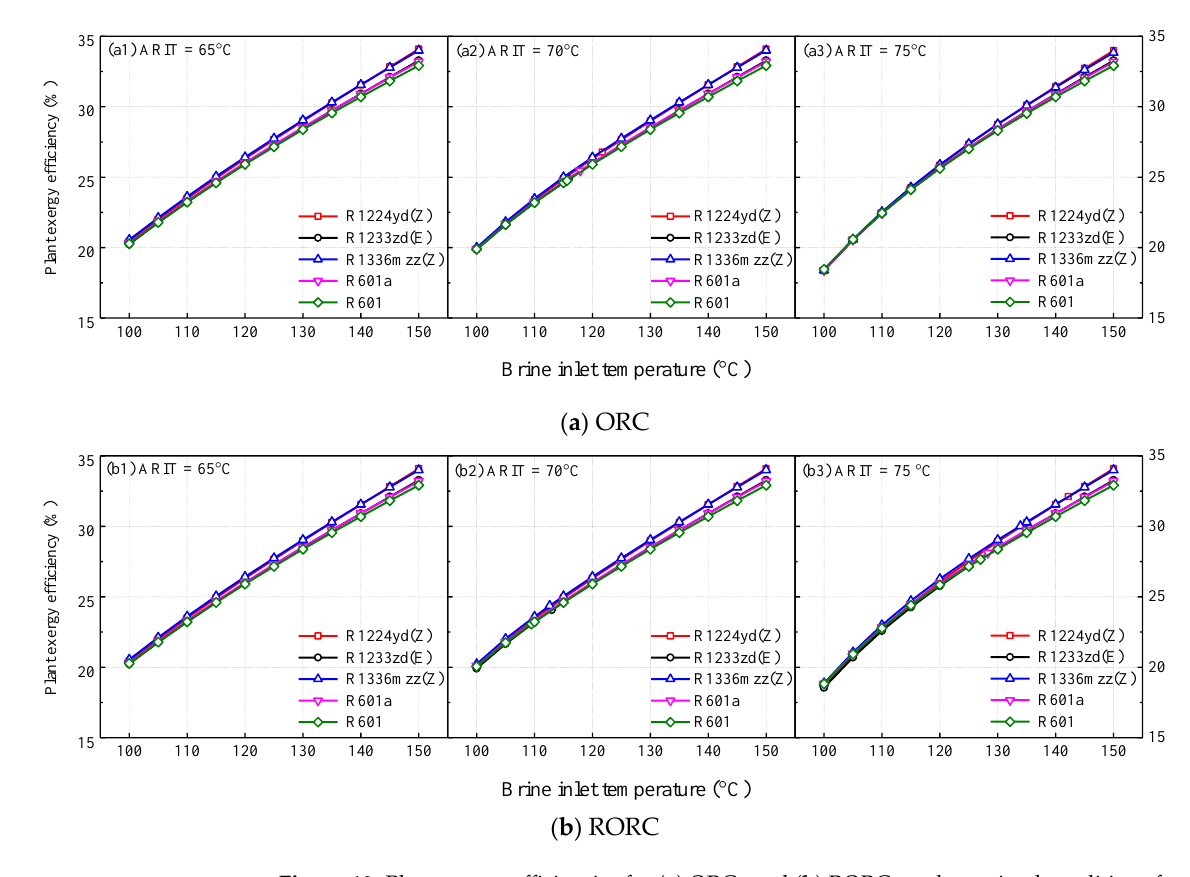
Figure 10. Plant exergy efficiencies for ( a ) ORCs and ( b ) RORCs at the optimal conditions for various ARITs and BITs.